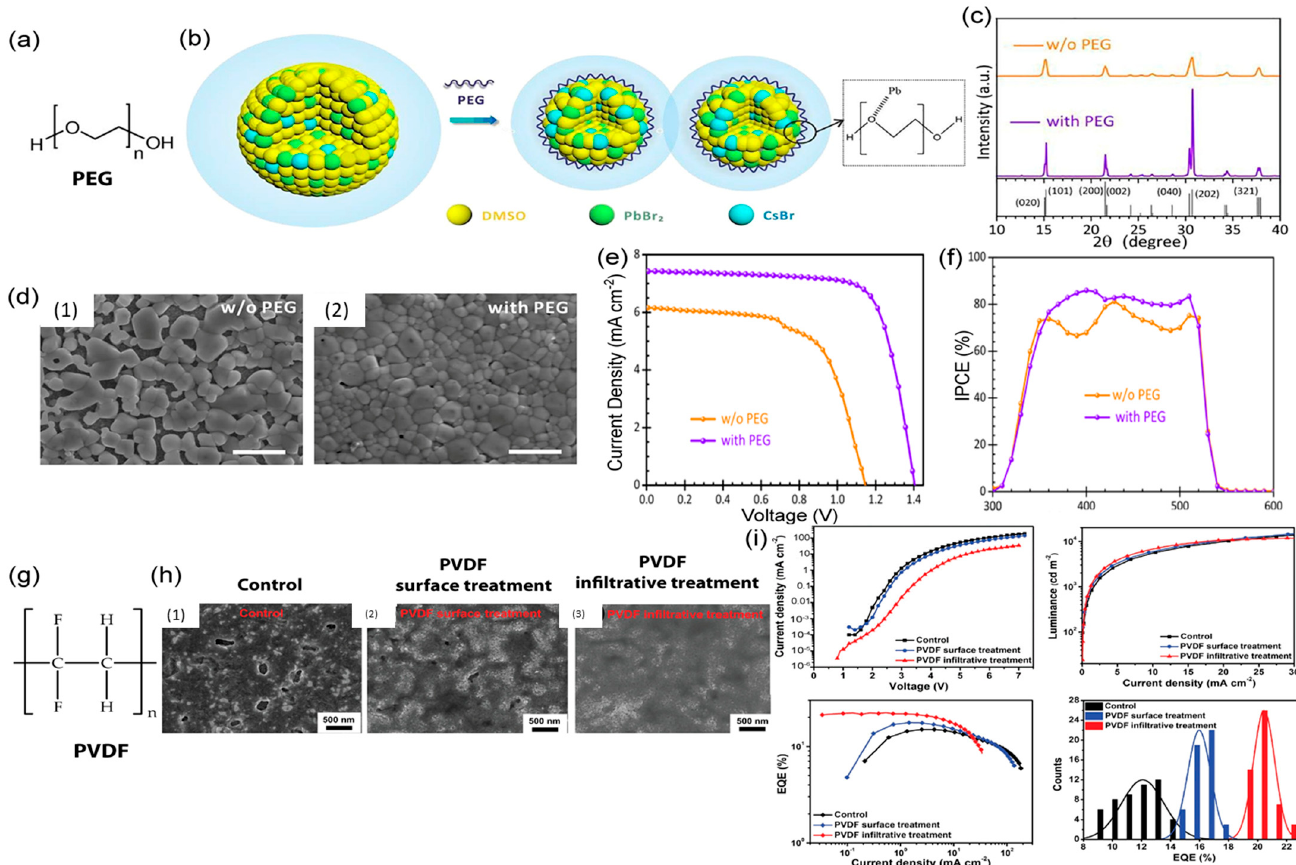
Figure 5. Polymer ‐ assisted crystallization: ( a ) molecular structure of polyethylene glycol (PEG); ( b ) an illustration of the increase in the number of colloids with the aid of PEG; ( c ) X − ray diffraction (XRD); ( d ) top ‐ view (SEM) images of calcined CsPbBr 3 perovskite thin layers prepared with and without PEG (the scale bar is 1 μ m); ( e ) J − V curve and ( f ) IPCE (%) vs. wavelength of corresponding CsPbBr 3 films [92]; ( g ) molecular structure of poly(vinylidene fluoride) (PVDF); ( h ) top − view SEM images for control, surface, and infiltrative treatment with PVDF (scale bar is 500 nm); and ( i ) device performance of corresponding PeLEDs [97]. Reprinted with permission.